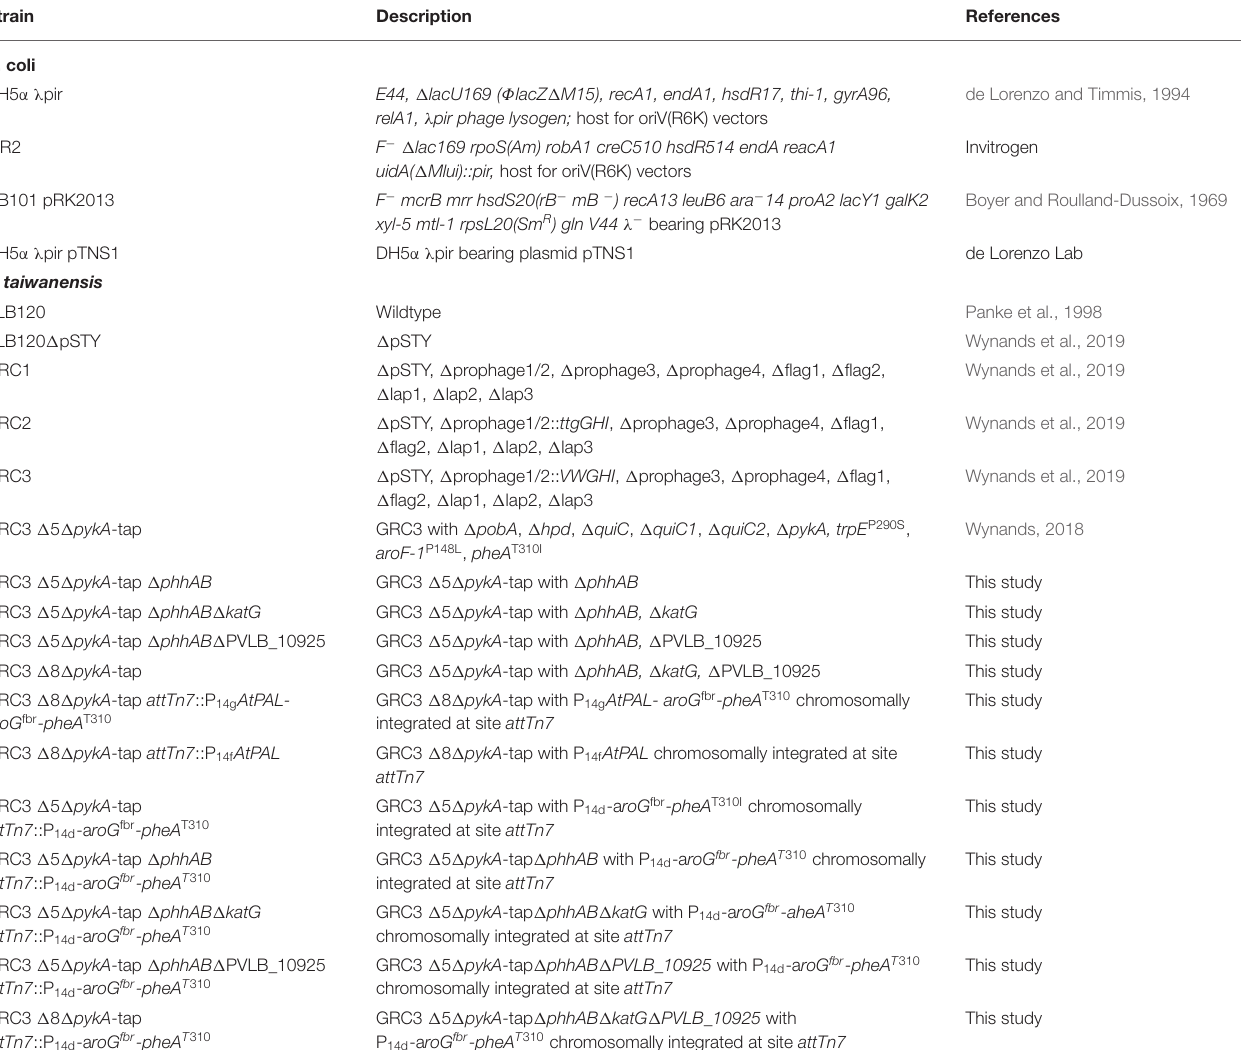
TABLE 2 | Bacterial strains. Strain